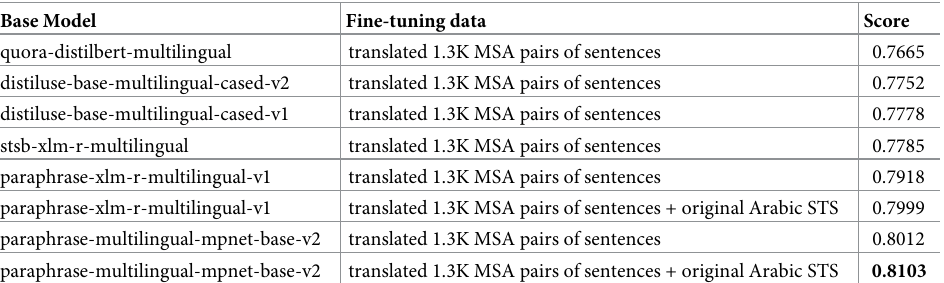
Table 4. Accuracy of knowledge distillation-based MSA models tested based on Spearman rank correlation between the cosine similarity of sentence representations and the reference labels of the testing dataset in [8].